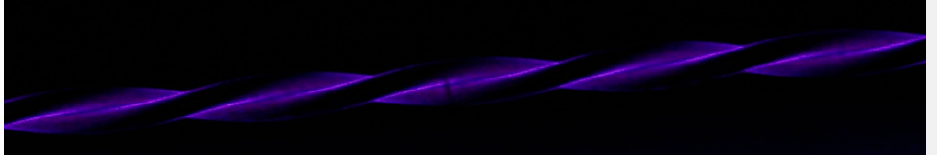
Figure 11. Example of optical PD observation by high sensitivity camera in TP sample during AC test.